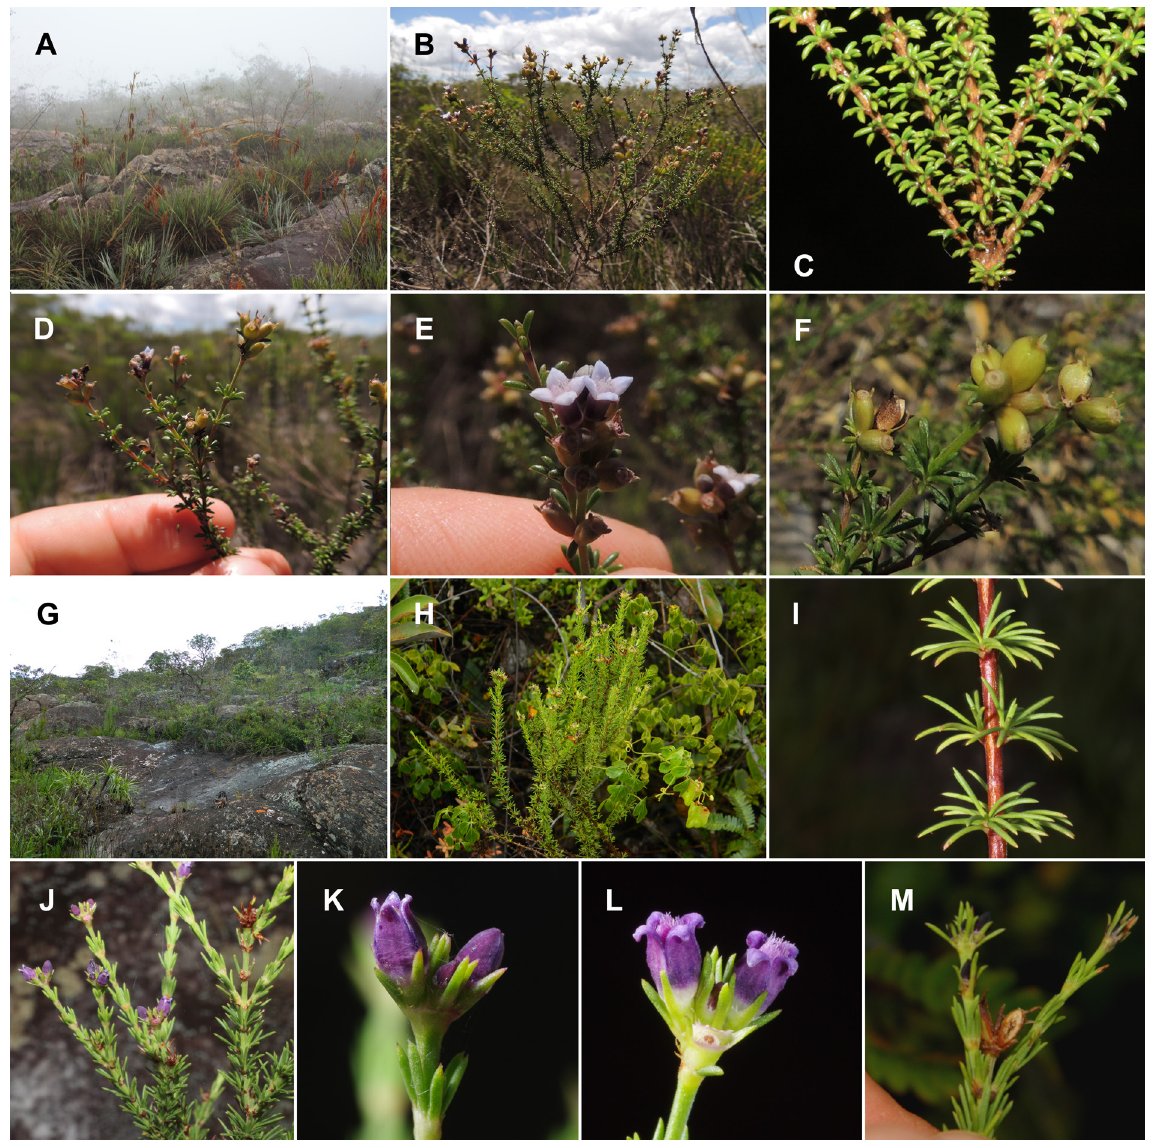
Fig. 6. A–F . Psyllocarpus itakangapyra Sobrado, J.A.M.Carmo & R.M.Salas sp. nov. A . Habitat,